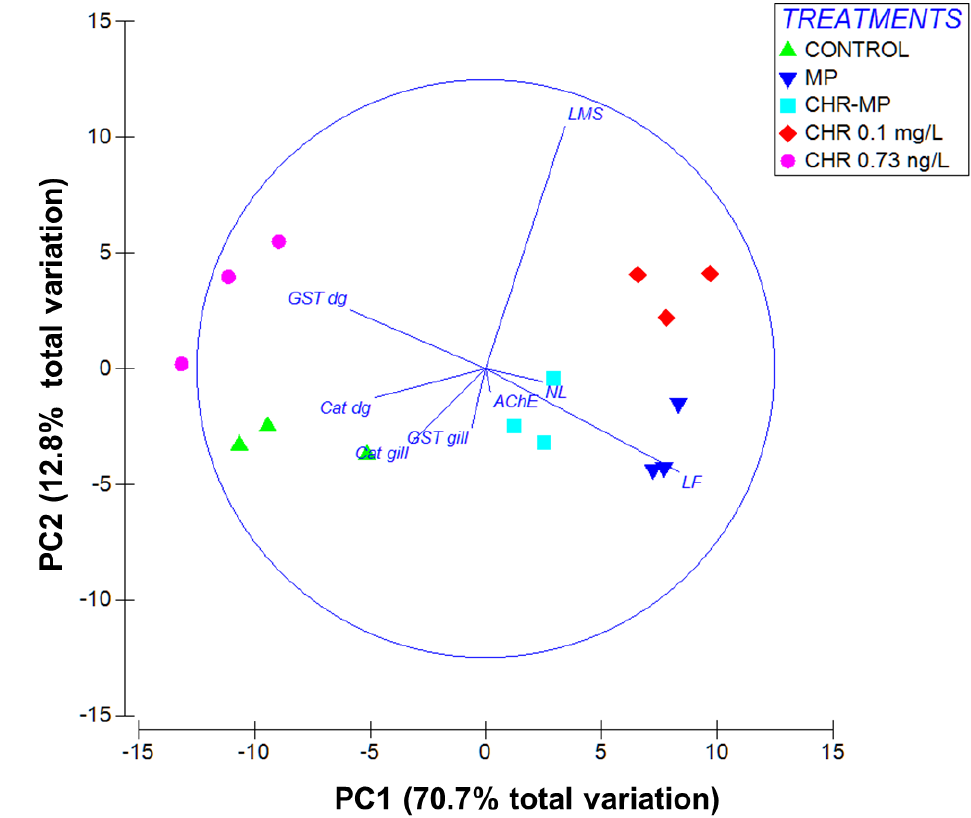
Figure 5. Biplot showing the output of the Principal Component Analysis (PCA) on biomarker data obtained in adult mussels exposed to polystyrene microplastics (MP), chrysene-loaded microplastics (CHR-MP), 0.1 mg/L and 0.73 ng/L of freely dissolved CHR. The first two axes accounted for the 83.5% of the total variance among